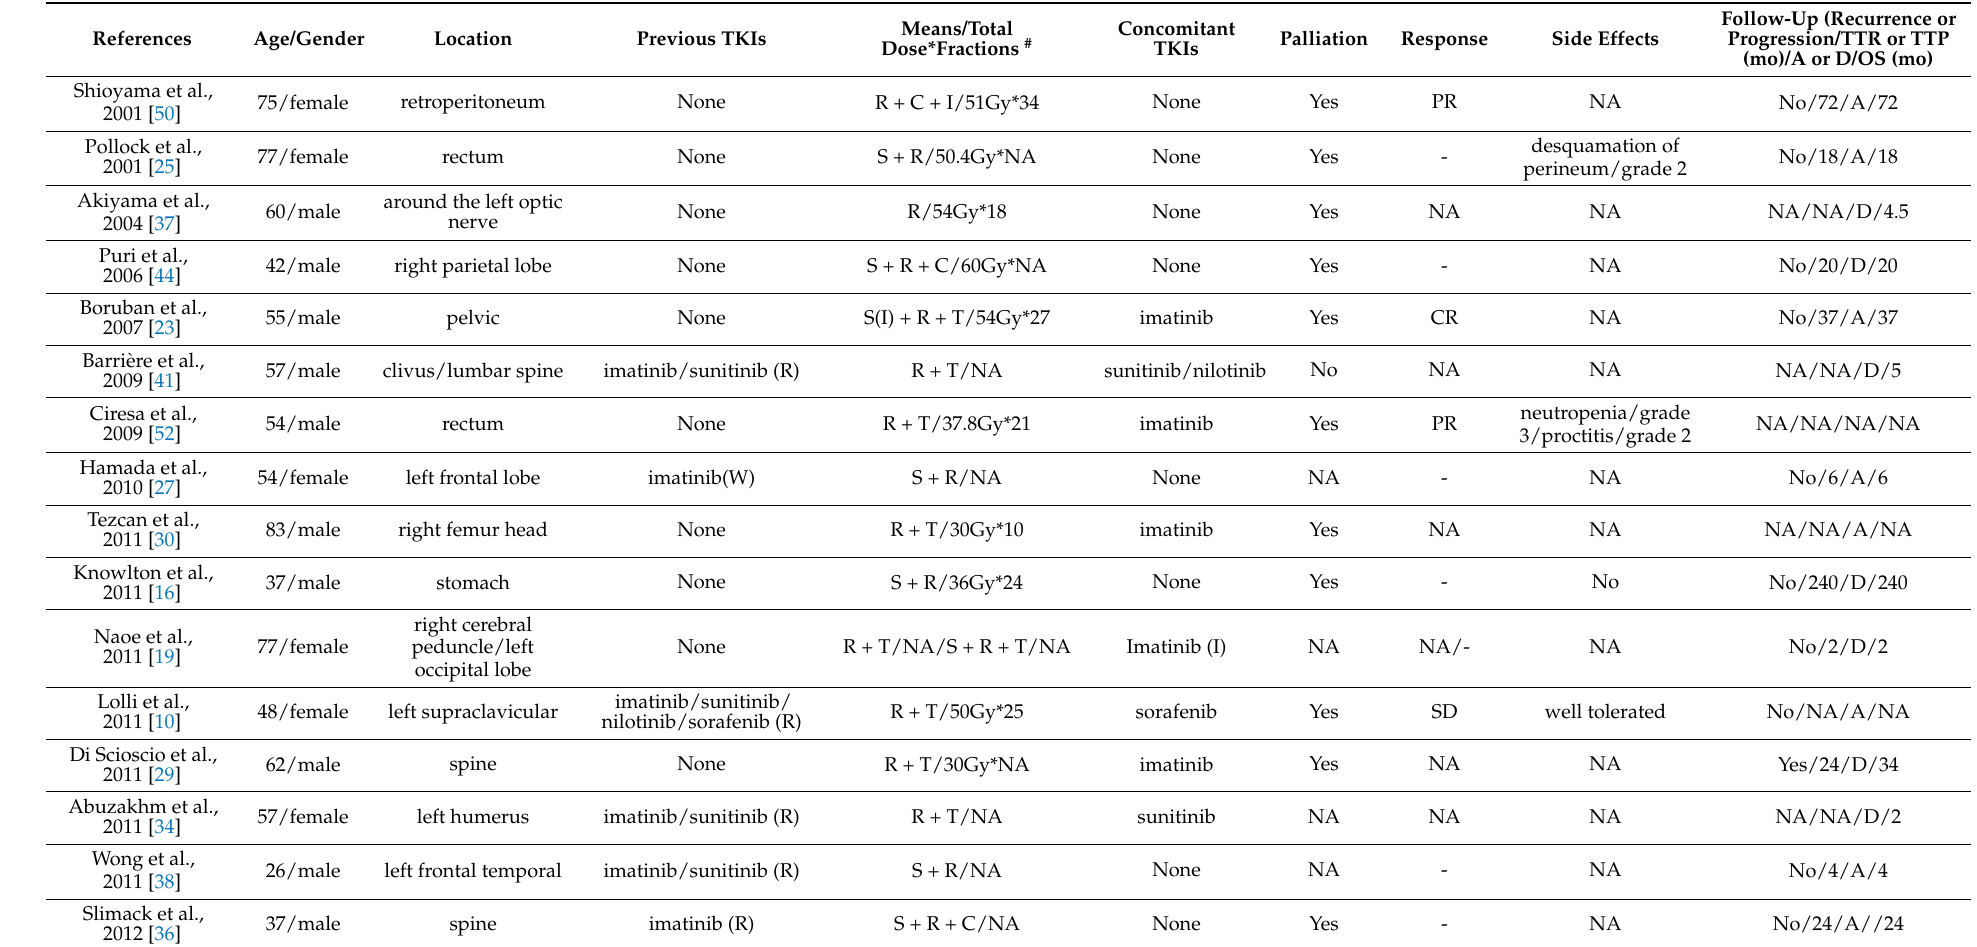
Table 1. Description of the cases treated by